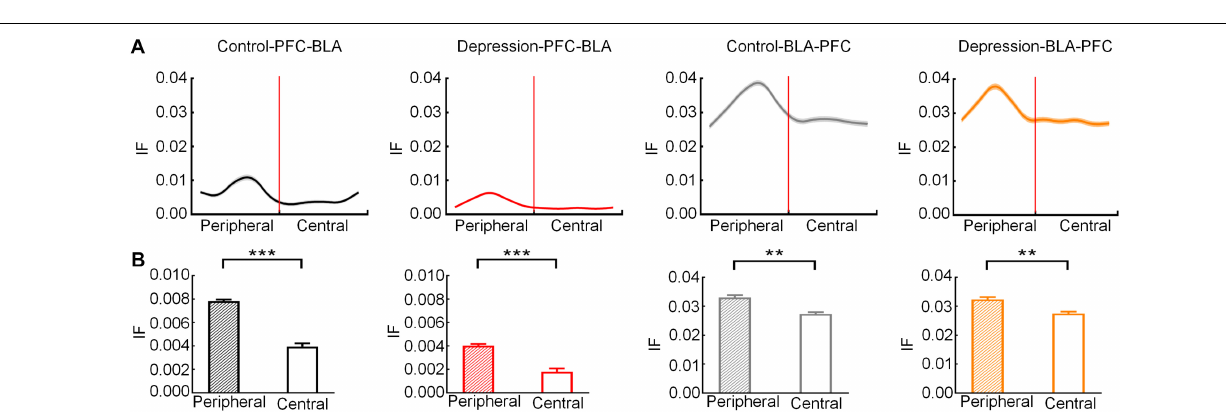
FIGURE 6 | Information flow (IF) of the mPFC-BLA and BLA-mPFC between the control and depression groups in the peripheral and central zones. (A) Averaged IF in the theta band from the peripheral zone to the central zone. The red line represents the RP. (B) Comparison of averaged theta IF in the peripheral and central zone. Error bars indicate SEM. Paired sample t -test, ** p < 0.01, *** p <